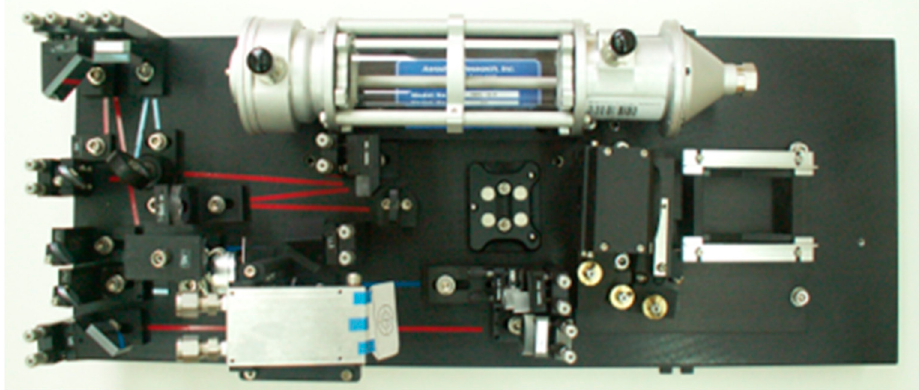
Figure 7. Analyzer